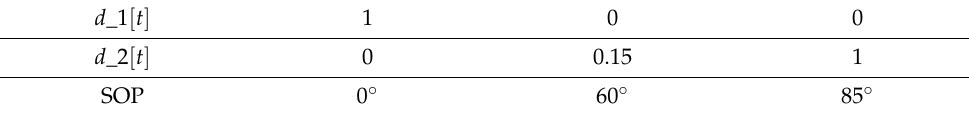
Table 2. SOPs of three-level polarization shift on–off keying (3PS-OOK). d _1 [ t ]